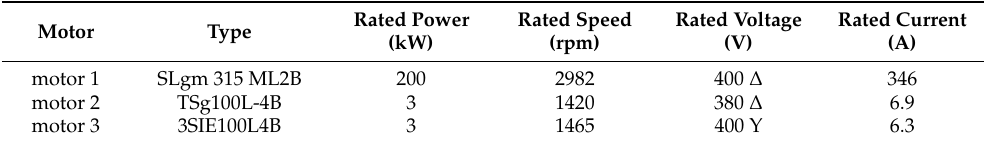
Table 1. Chosen parameters of the investigated